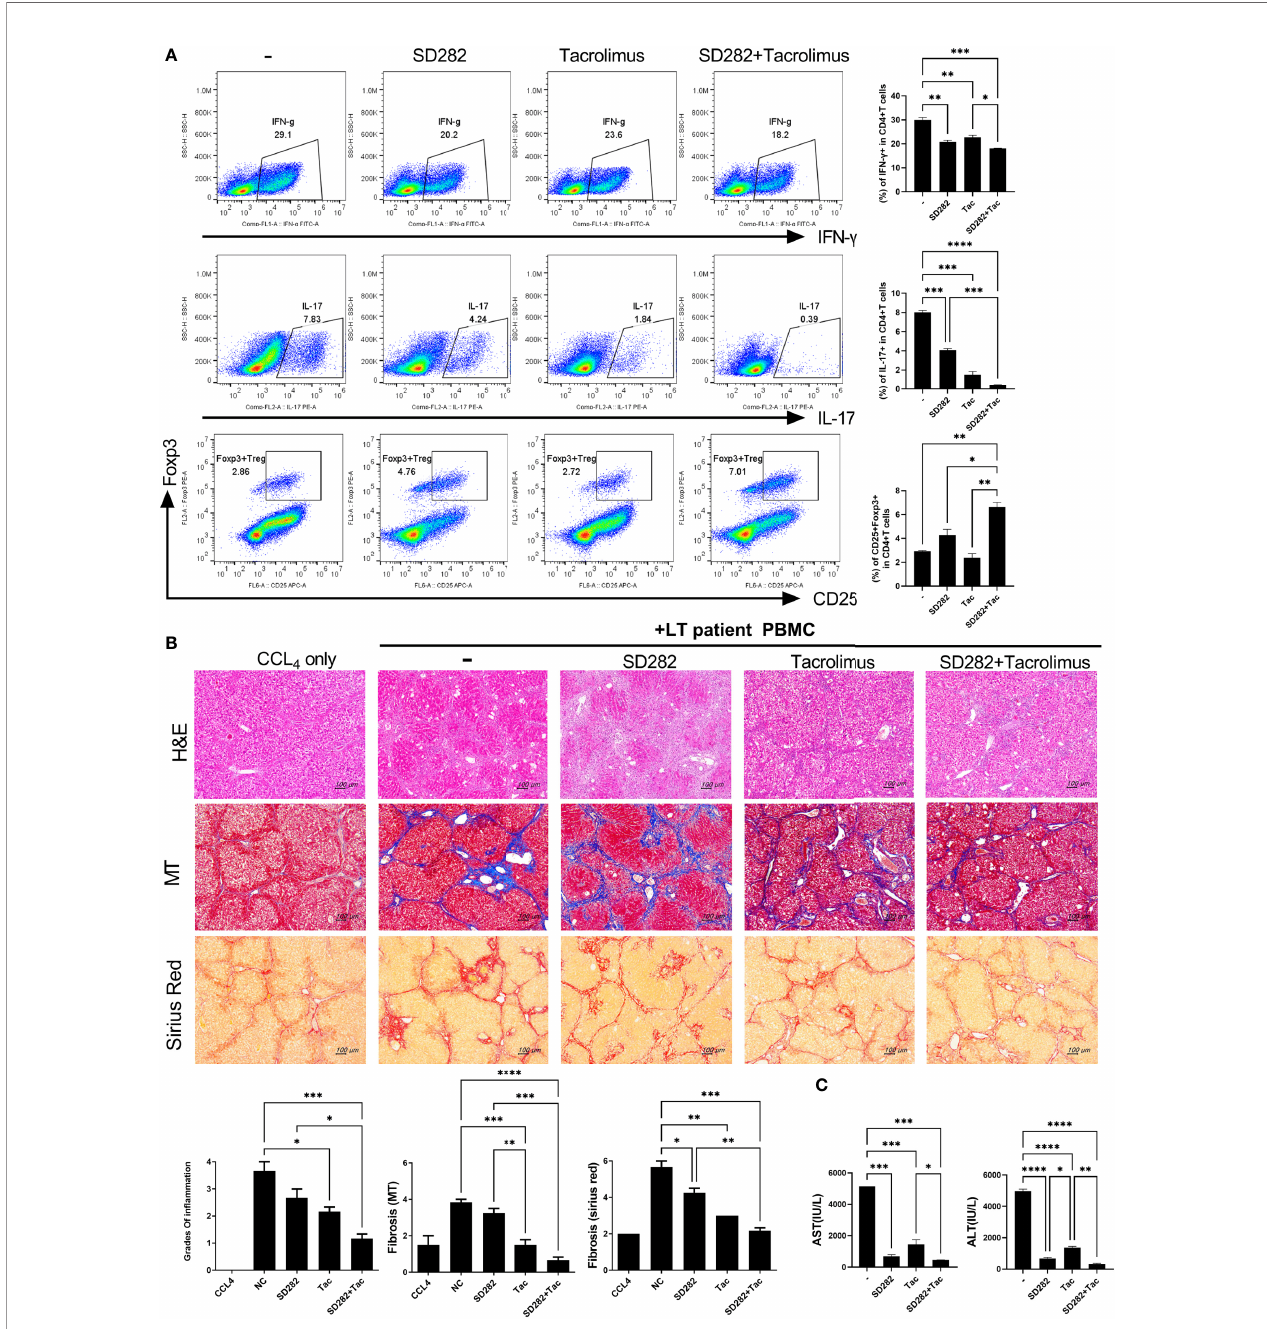
FIGURE 6 | Change in T-cell subtypes ( in vitro analysis) and liver histology of avatar models after combination treatments of tacrolimus and SD282 (biguanide derivatives). (A) Human CD4 + T cells from PBMCs were cultured in the presence or absence of SD282 or/and tacrolimus under the anti-CD3 stimulation condition for 3 days. The populations of Th1, Th17, and Foxp3 + Tregs were analyzed by fl ow cytometry. (B) Changes in liver histology of avatar models after SD282 and tacrolimus combination therapy. Liver tissue sections were harvested from humanized mice at 7 weeks after adoptive transfer with PBMC preparations from liver transplantation patients. Humanized mice were orally administered vehicle (NC) or SD282 and/or tacrolimus once every day for 4 weeks. Representative images of H&E, MT, and Sirius red staining of paraf fi n-embedded mouse liver tissue sections are shown in the upper panel. In fl ammation and fi brosis scores are shown in the lower panel. (C) Serum AST and ALT levels in humanized mouse model. Data are the means±SEM of two replicates. * P < 0.05, ** P < 0.01, *** P < 0.001, **** P < 0.0001. IHC, immunohistochemistry; PBMC, peripheral blood mononuclear cell; SD282, N-ethyl-N-(4- fl uorophenyl) biguanide derivatives; H&E, hematoxylin and eosin; MT, Masson ’ s trichrome; AST, aspartate aminotransferase; ALT, alanine